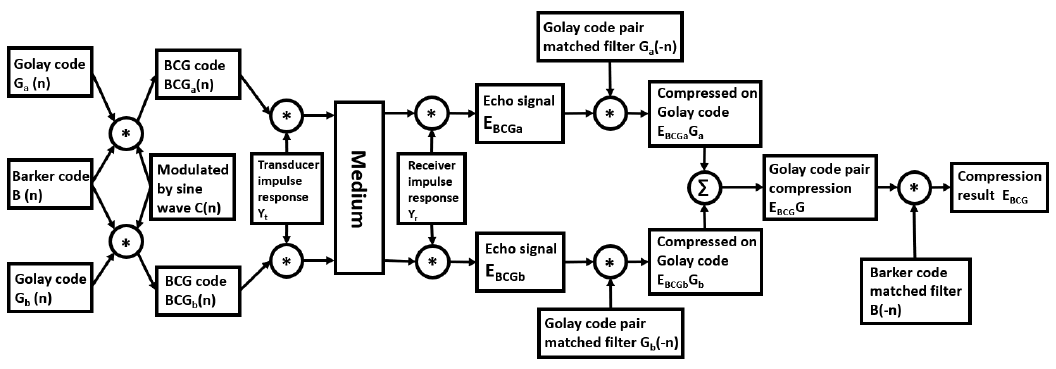
Figure 3. The process of generation and compression of Barker-sequence combined Golay codes